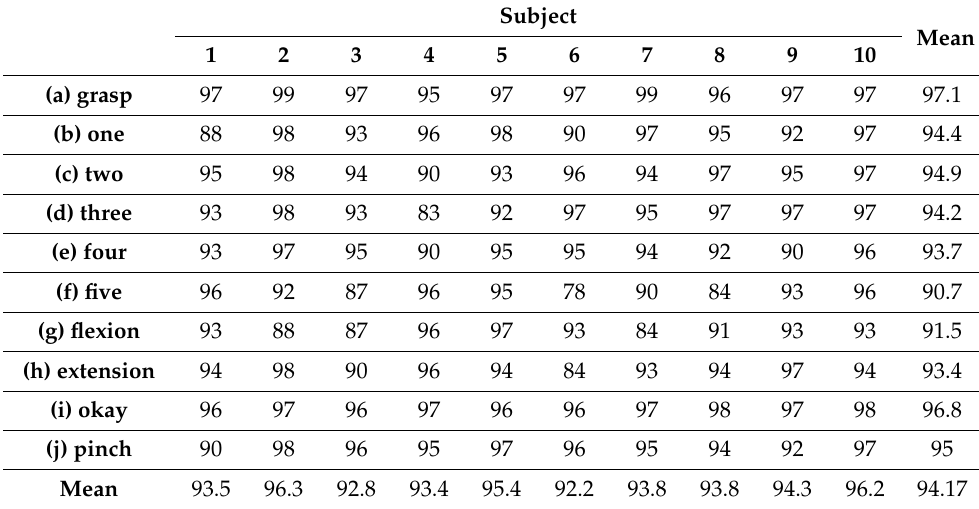
Table 1. Classification accuracy of 10 hand postures using the proposed convolutional neural network (CNN) when their own data were used for the